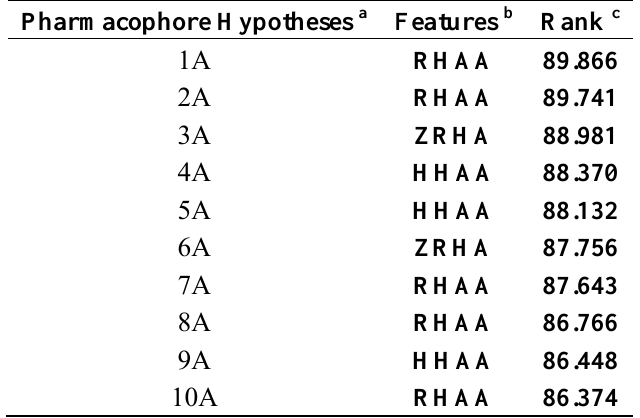
Table 1. Common feature pharmacophore hypotheses generated based on training set compounds.